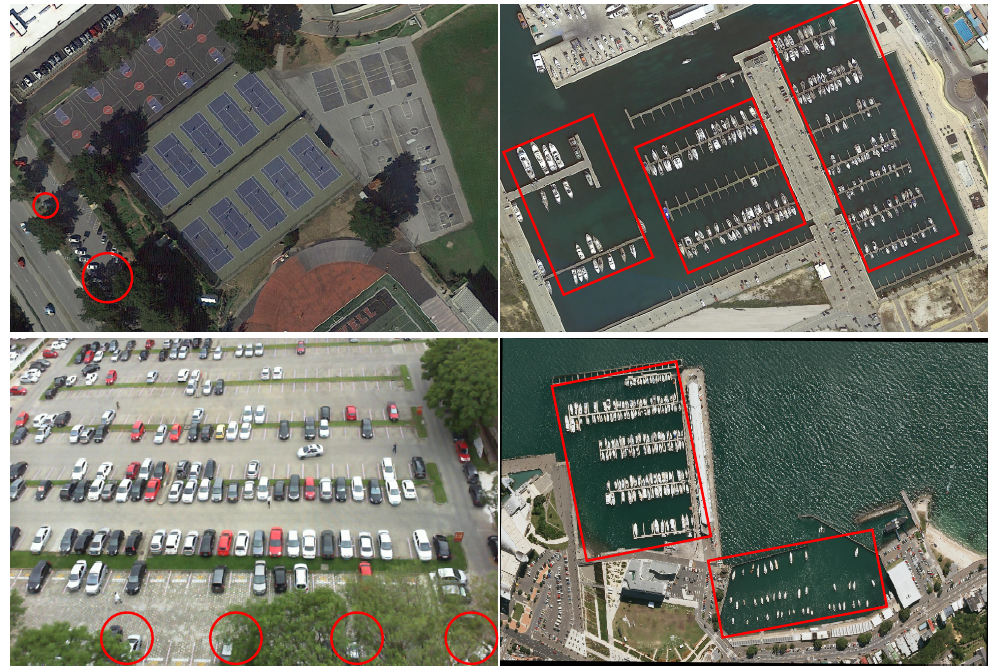
Figure 1. Examples of objects with scale variation and background clutter in remote